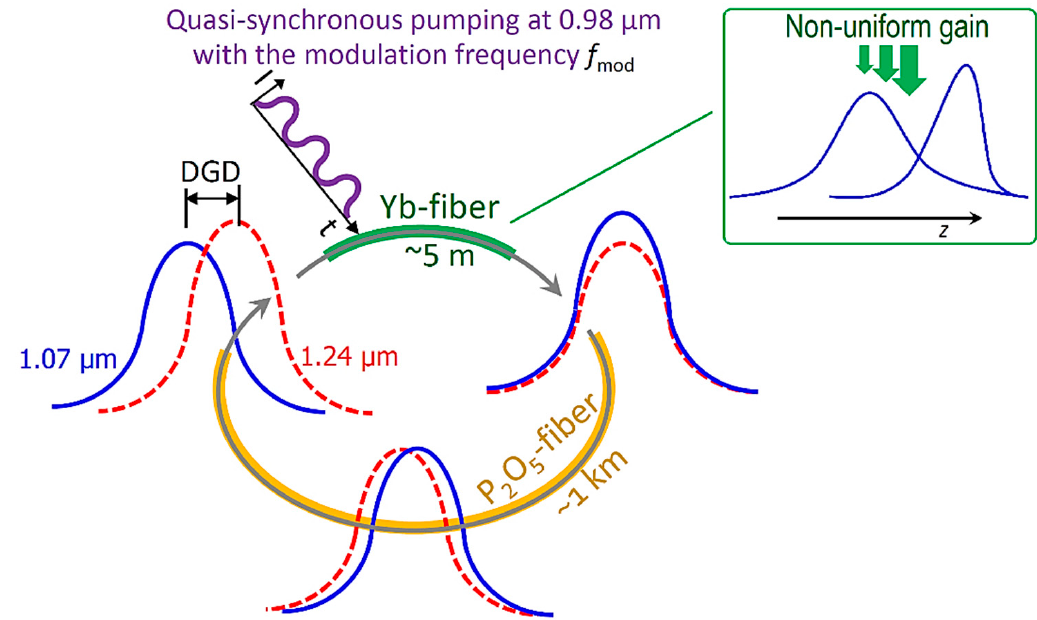
Figure 1. Concept of synchronized dual-wavelength (~1.07 μ m and 1.24 μ m) pulsed lasing in a hy- brid (Yb-based and Raman-based) single-cavity fiber laser with a quasi-synchronous primary pumping (at 0.98 μ m), which provides active compensation of differential group delay (DGD) be- tween the fundamental (1.07 μ m) and Stokes (1.24 μ m) pulses. This DGD inevitably arises during intracavity round trip because of large normal chromatic dispersion introduced by a long Raman